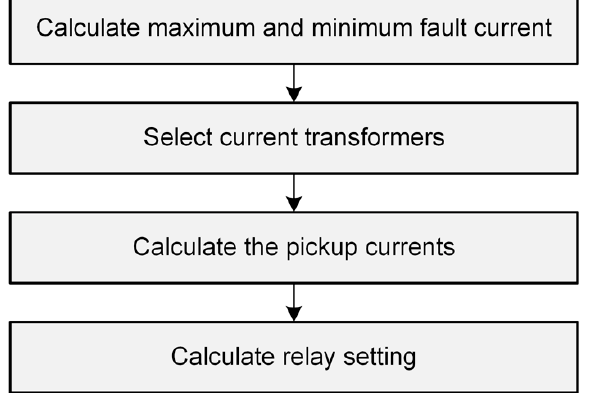
Figure 4. Process of designing protective relays.